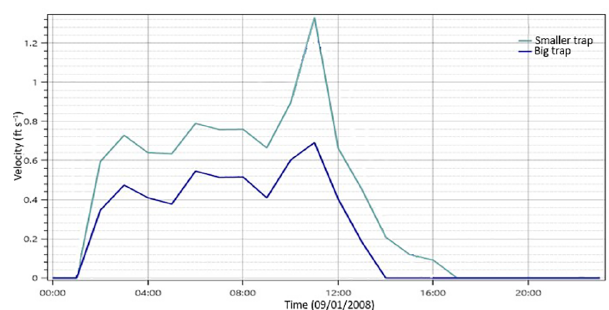
Figure 9. Effects of Stream Modification in the Water Velocity at the Dean-Road Bridge Cross Section Calculated by